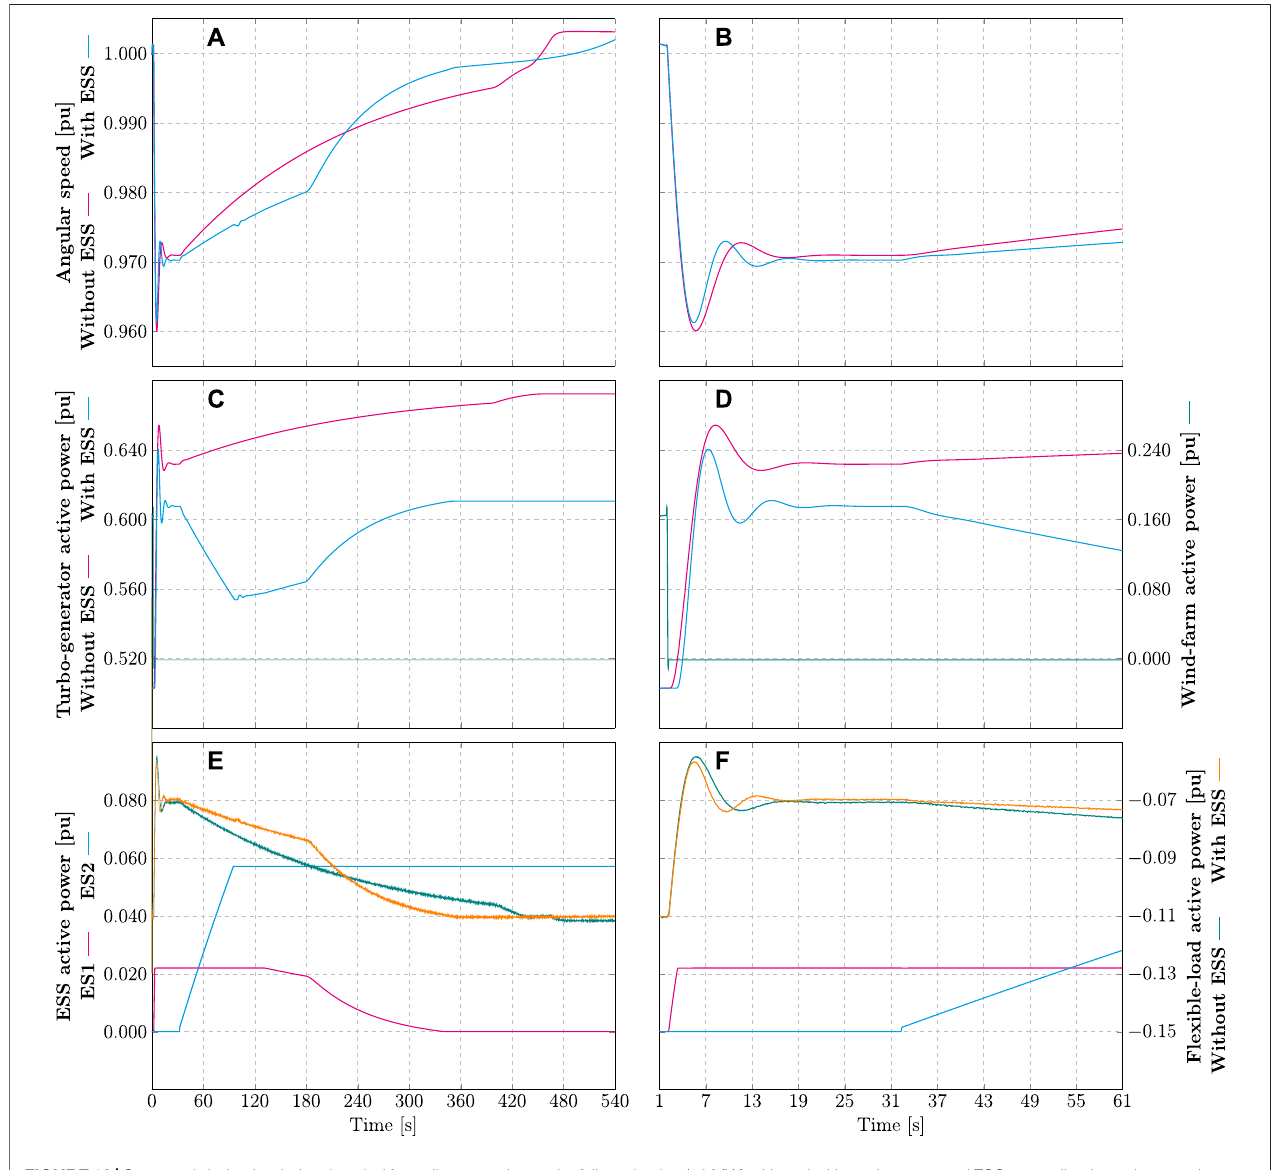
Frontiers in Energy Research |